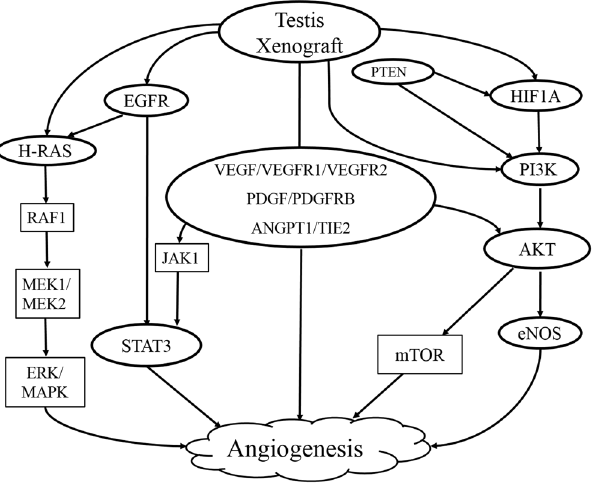
Figure 7. Schematic representation of pathways involved in angiogenesis of xenografted testis tissues. Signalling proteins denoted inside the oval shape were found to have role in testis xenograft angiogenesis and the ones indicated inside the rectangle shape did